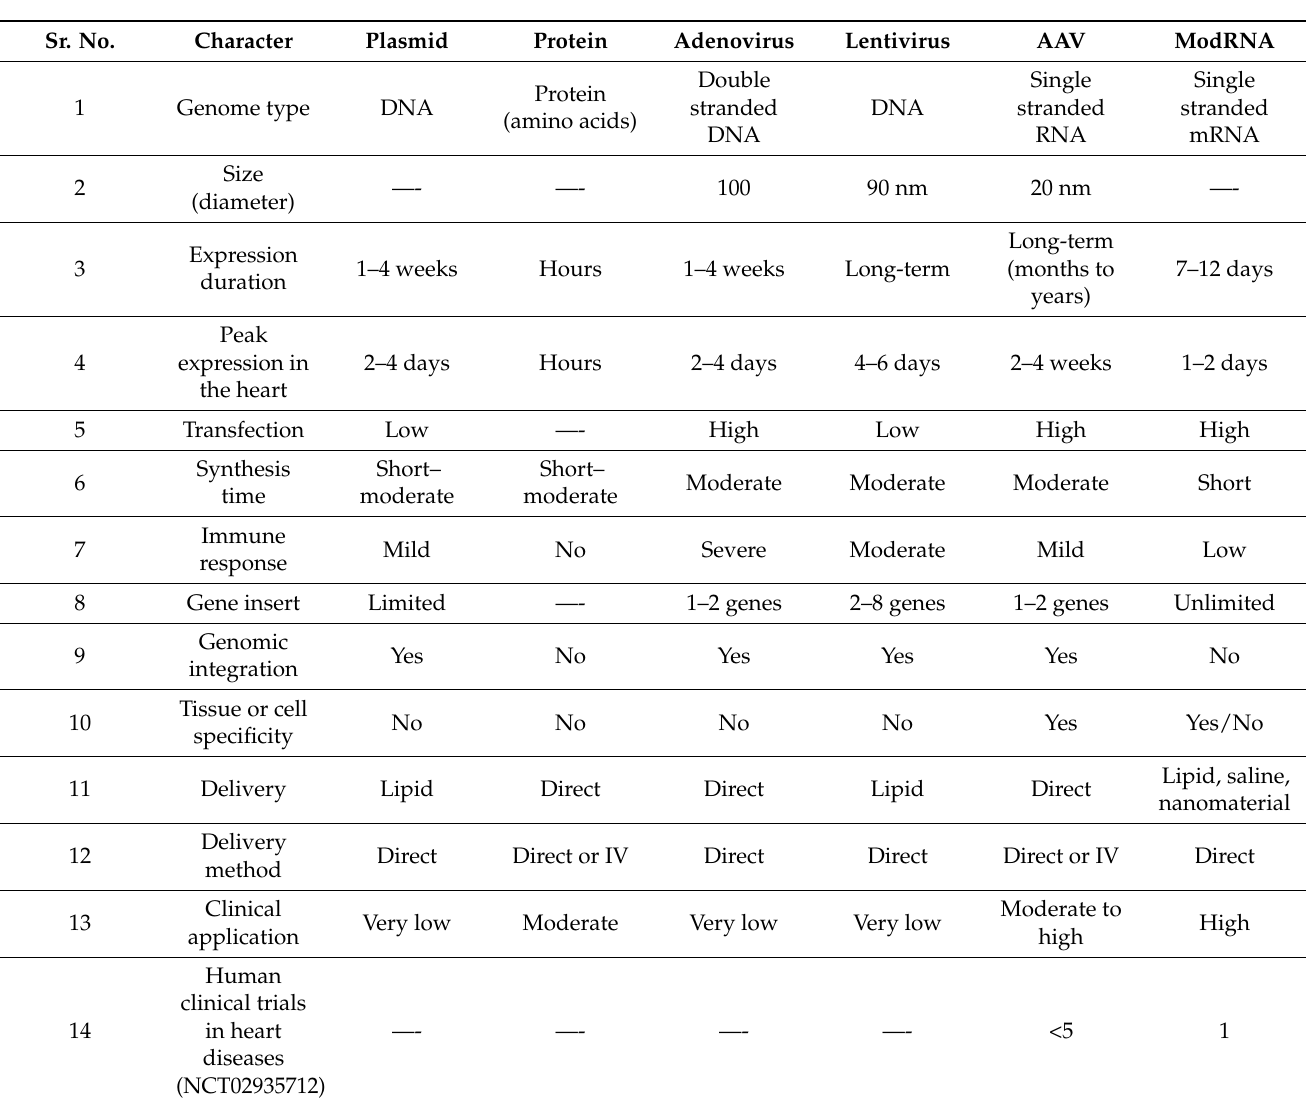
Table 1. Vectors used in the cardiovascular system to deliver gene therapies: vector characteristics, application and